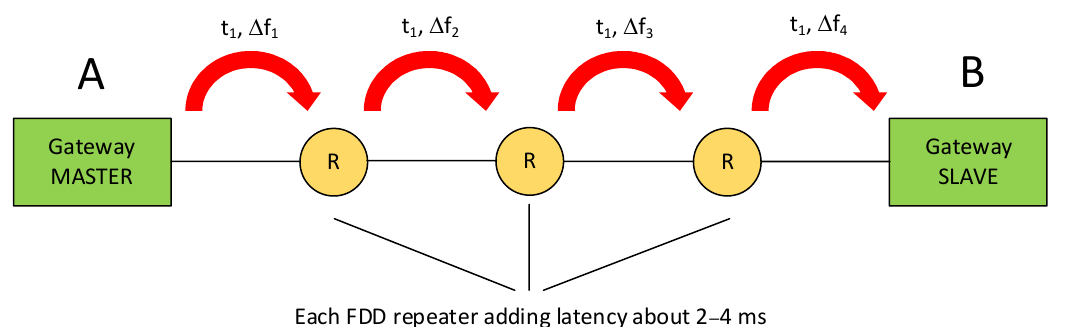
Figure 3. Data transmission from point A to point B using repeaters (R) in an FDD scenario.